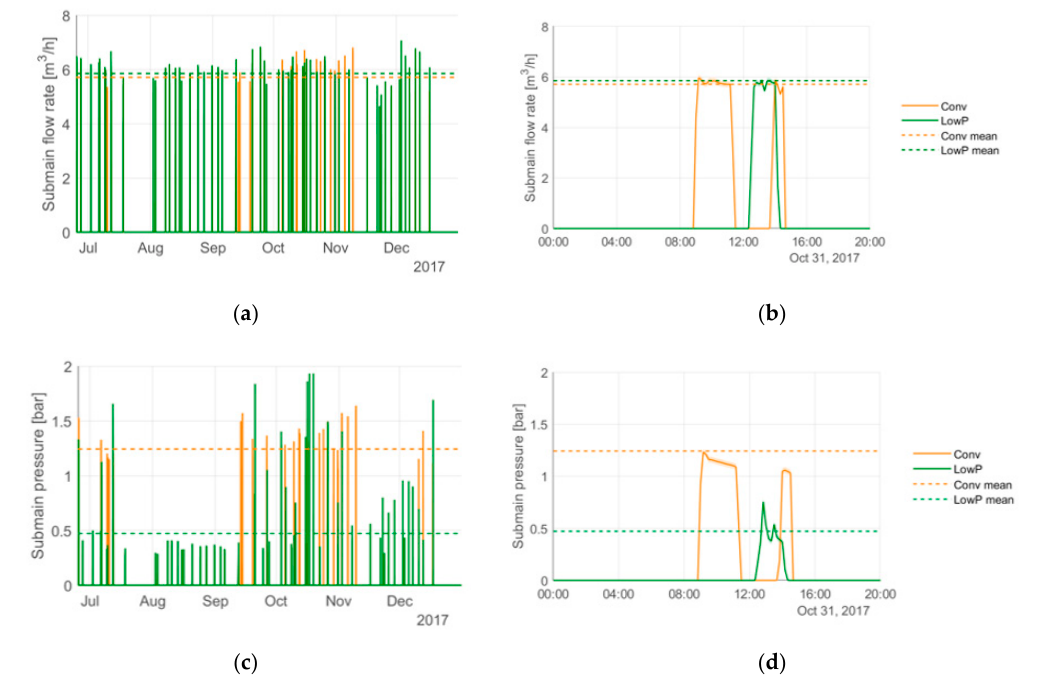
Figure 5. Example of submain ( a ) flow rate, and ( c ) pressure sensor data collected during the 2017 irrigation season for low-pressure ( LowP ) and conventional ( Conv ) emitter plots at the Sharhabeel site with pomegranates. The mean values over the season are shown with dashed lines. Zoom in on one day of sensor data for ( b ) flow rate and ( d ) pressure, comprising one irrigation event on the low-pressure emitter plot and two irrigation events on the conventional emitter plot. The low-pressure emitters delivered the same flow rate at a submain pressure of 40–60 kPa (0.4–0.6 bar) as the conventional emitters at a pressure of 100–120 kPa (1.0–1.2 bar).